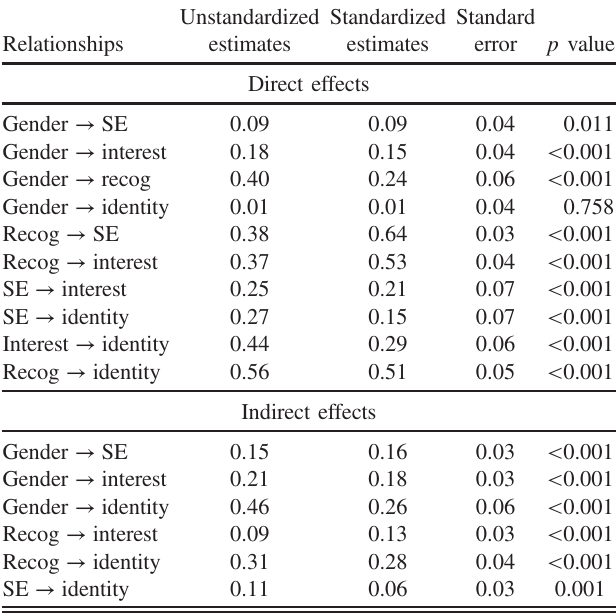
TABLE VI. Results of the path analysis part of SEM model 2 for physics 1. Recog represents perceived recognition. SE represents self-efficacy. Single-headed arrows represent direct or indirect regression relationships.